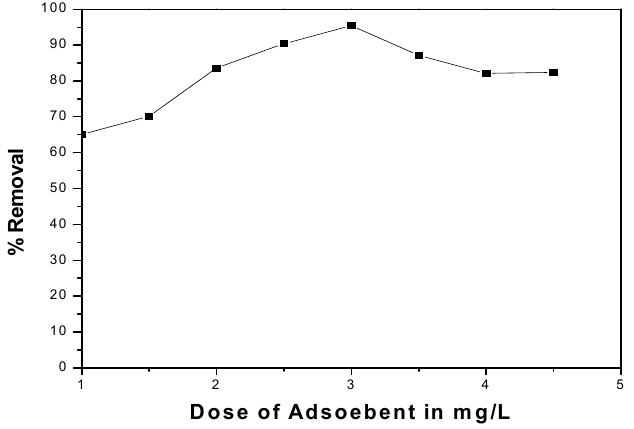
Fig.11. Effects of adsorbent dosage on Pb(II) ions removal.